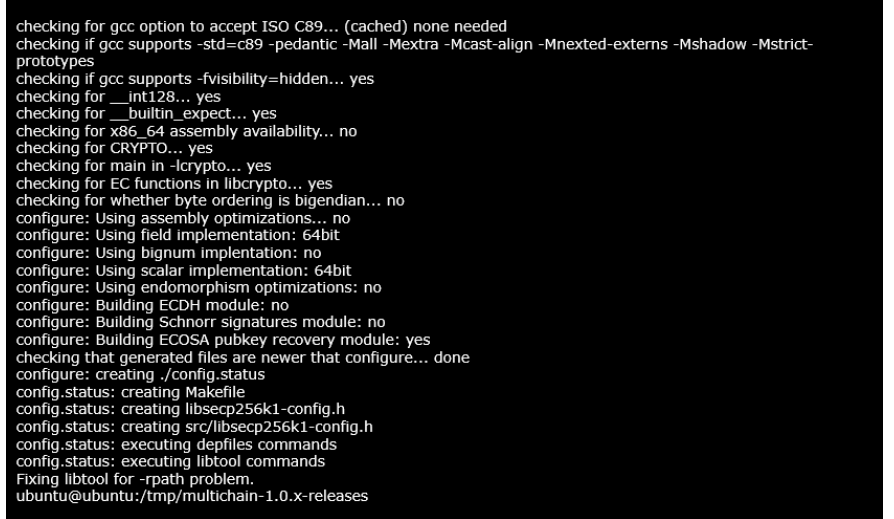
Figure 12. IoT blockchain built and running on Raspberry Pi. Algorithm of IoT blockchain connectivity is evaluated with these small